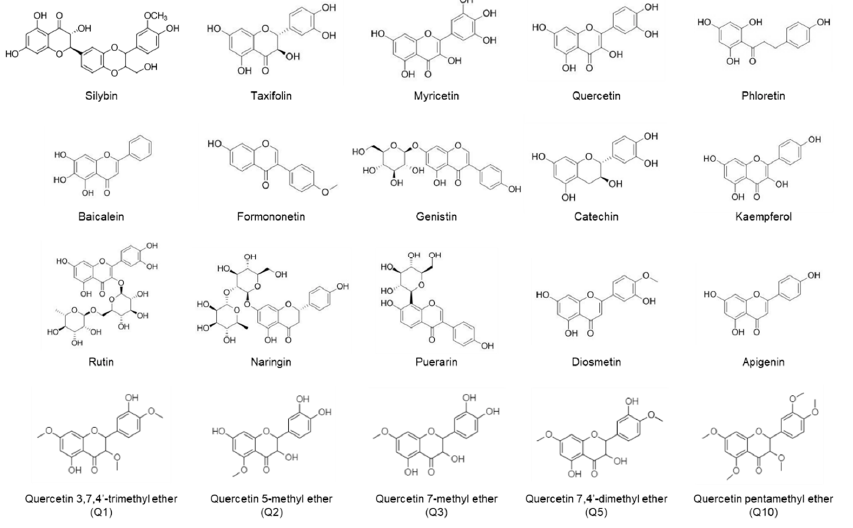
Figure 1. Structures of flavonoids.